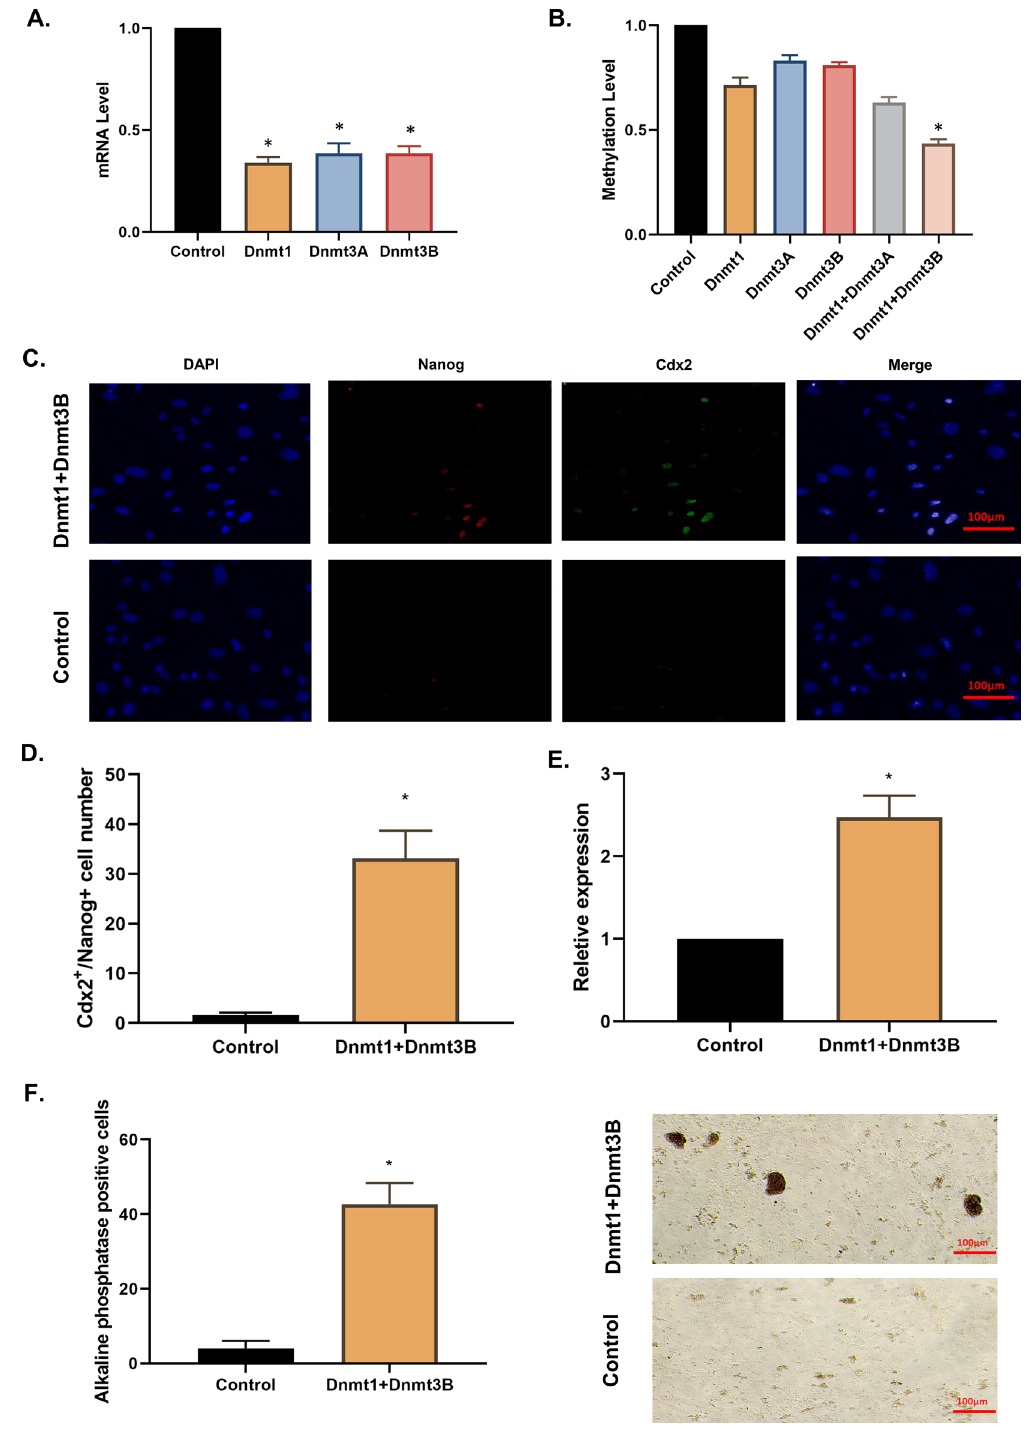
Figure 3. Dnmt1 and Dnmt3B could induce a totipotent state in fibroblast. ( A ) Dnmt1, Dnmt3A, and Dnmt3B result in efficient reduction of the mRNA level of these genes (*P < 0.05 for all groups versus treated cells with scramble control). ( B ) Dnmt1 and Dnmt3B knockdown results in significant DNA demethylation in comparison with control group (*P < 0.05). ( C ) Knockdown of Dnmt1 and Dnmt3B results in induction of Nanog and Cdx2 positive cells. ( D ) Number of Nanog and Cdx2 positive cells in the Dnmt1 and Dnmt3B Knockdown group is significantly higher in the control group which is almost complete absence of these cells (*P < 0.05). ( E ) Overexpression of MERVL detected in absence of Dnmt1 and Dnmt3B versus non treated fibroblast (*P < 0.05). ( F ) Cells treated with Dnmt1 and Dnmt3B show alkaline phosphatase activity (*P <